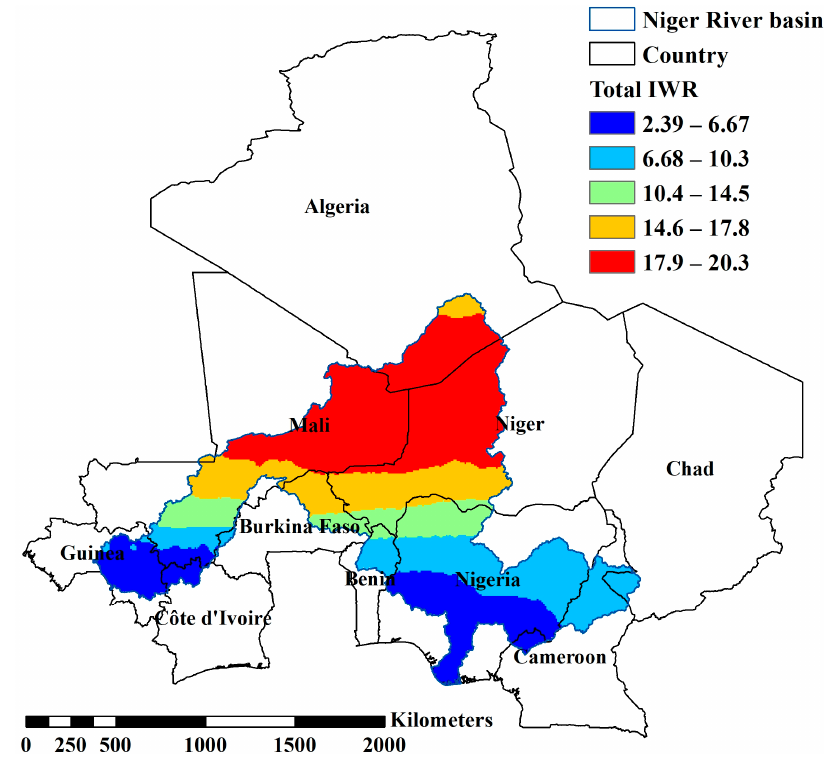
Figure 12. IRW under MIROC 5. It shows the global irrigation water requirements in different countries in the basin under the RCP 8.5.